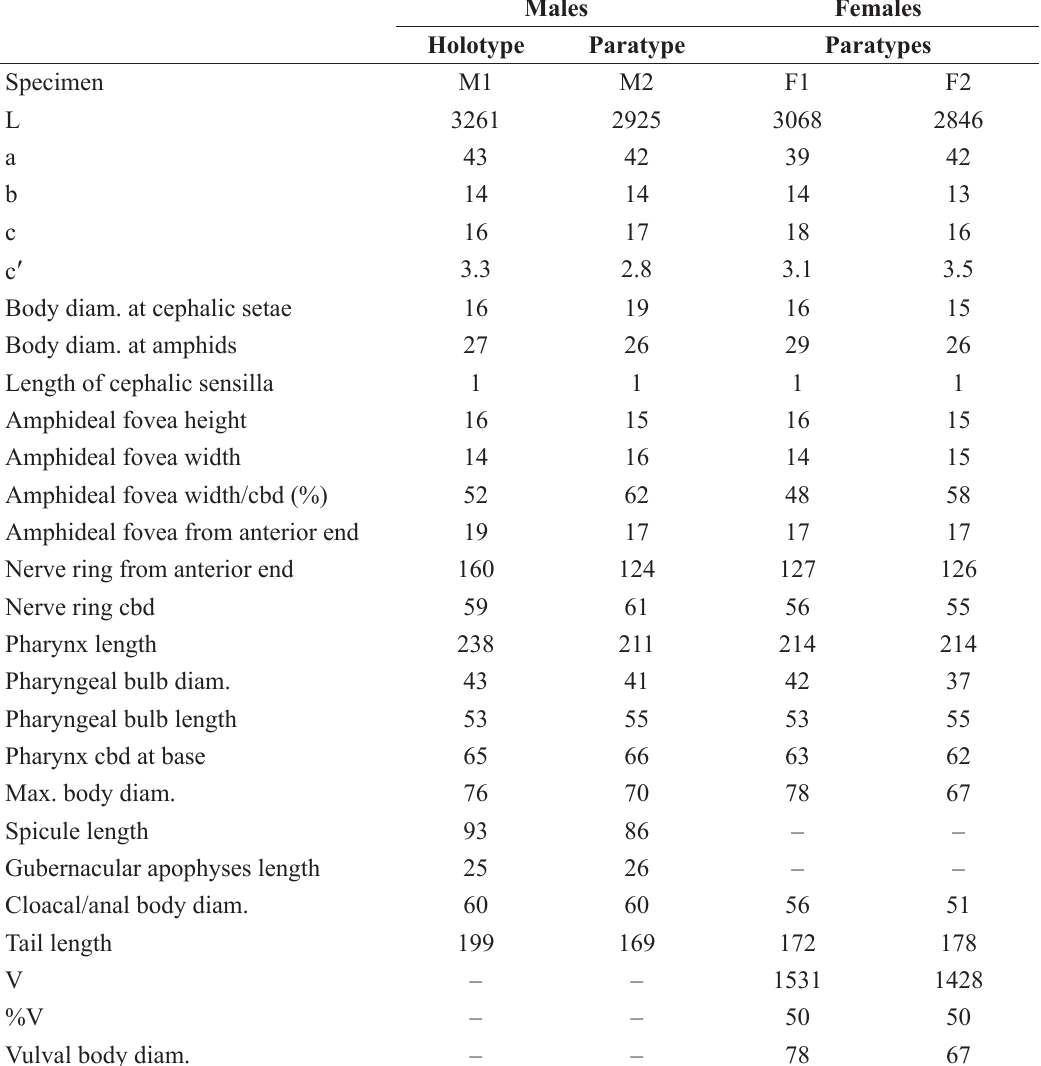
Table 6. Morphometrics (µm) of Aegialoaliamus magnus sp. nov. Abbreviations: a = body length/ maximum body diameter; b = body length/pharynx length; c = body length/tail length; cʹ = tail length/ anal or cloacal body diameter; cbd = corresponding body diameter; L = total body length; V = vulva distance from anterior end of body; %V = V/total body length ×